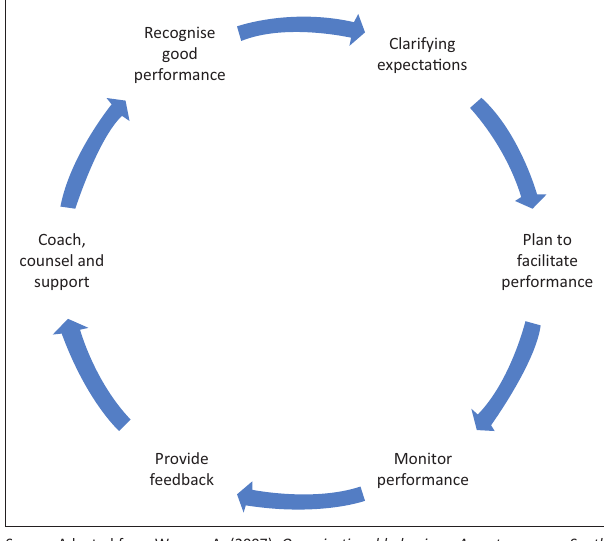
FIGURE 1: Individual performance management